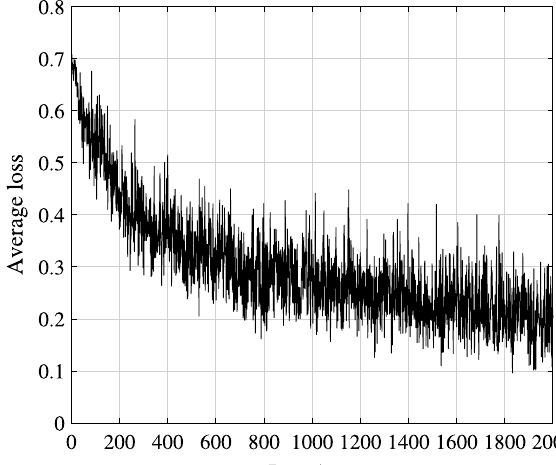
Fig. 8 Training loss of the Siamese